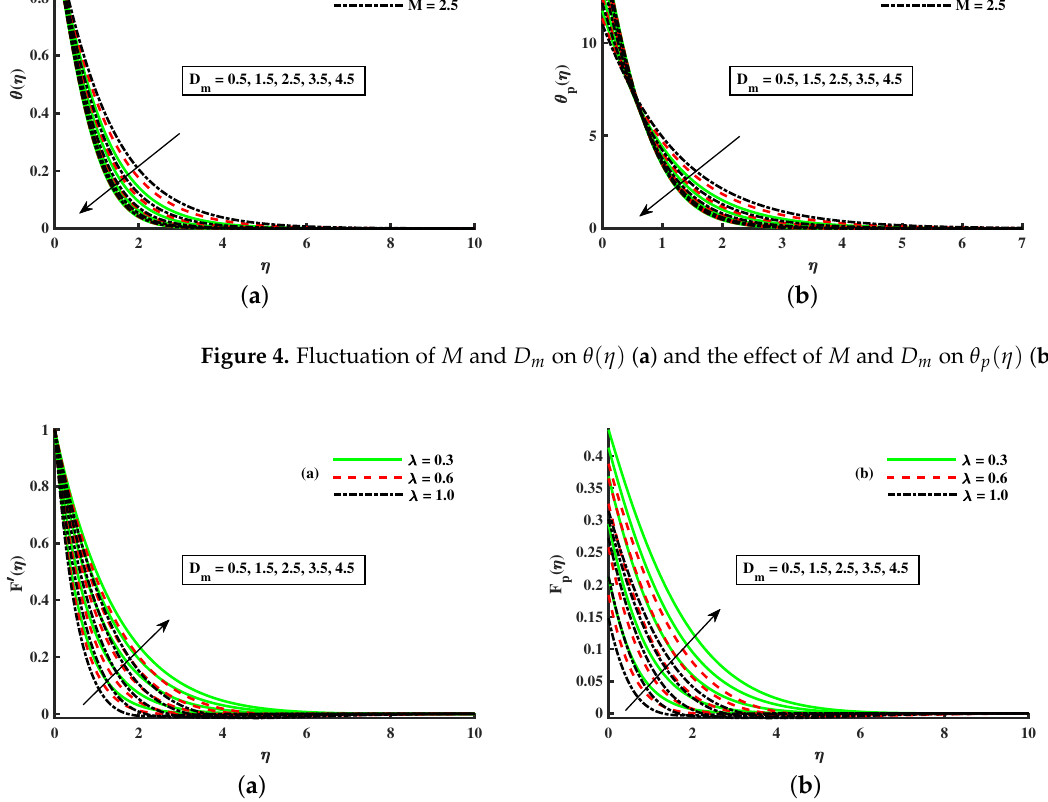
Figure 5. Fluctuation of λ and D m on F (cid:48) ( η ) ( a ) and the effect of λ and D m on F p ( η ) ( b